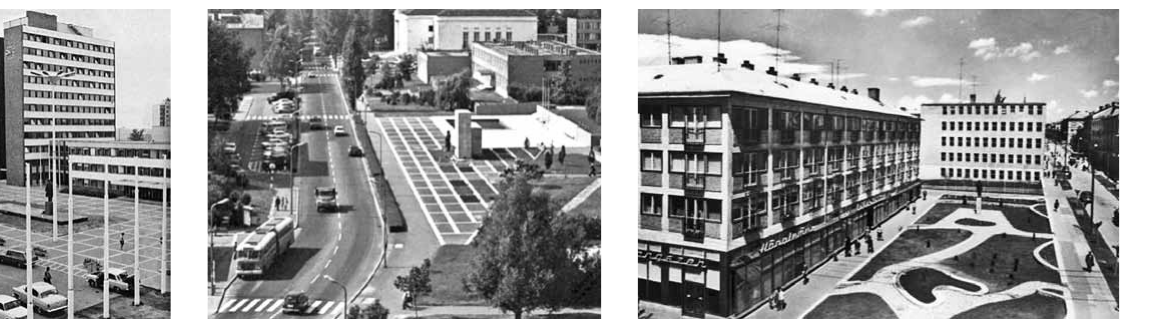
fig. 8. a new, regularly shaped public square with a free standing sculpture on it, created in the ’50s in the historical town of